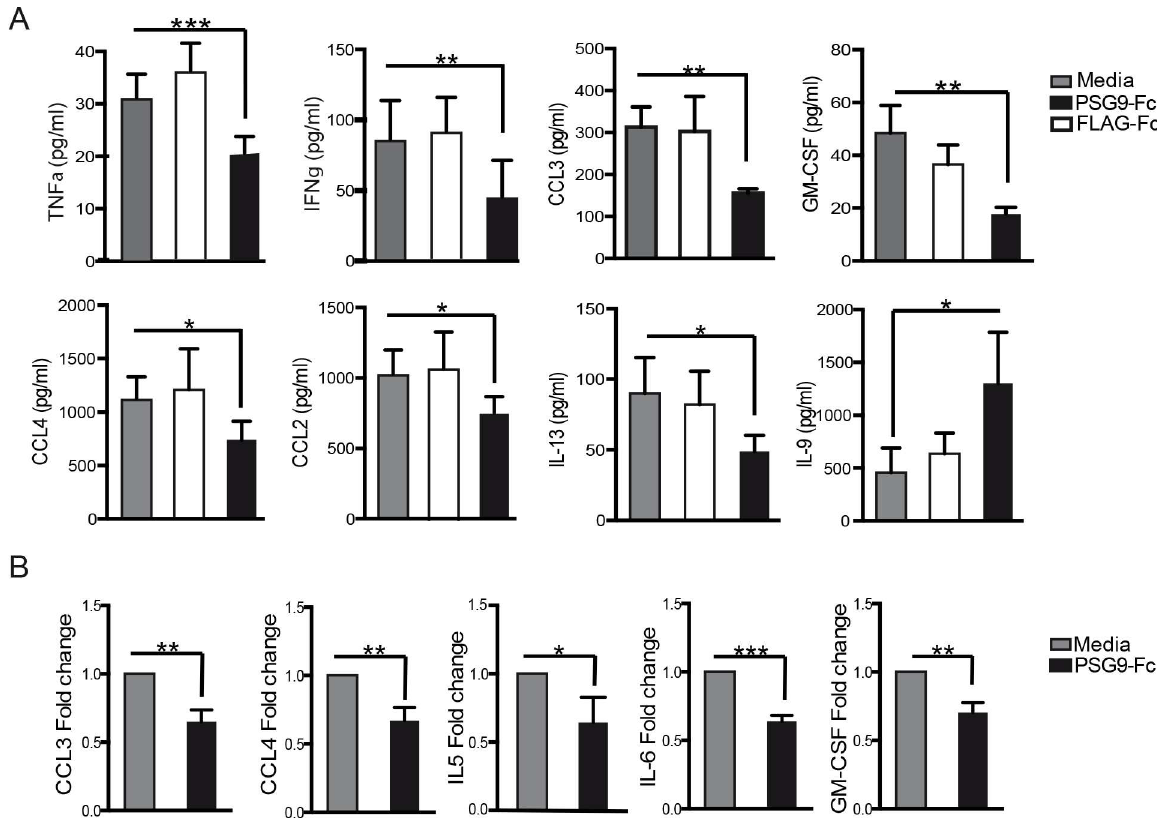
Fig 8. Pro-inflammatory cytokine expression is reduced upon T-cell treatment with PSG9. Supernatants from naive CD4 + mouse (A) or human(B) T-cells were collected 72 h after activationand treatment with PSG9 or FLAG. Cytokineconcentrations were measuredusing multipleximmunoassay kits with the Bioplex system. P values were calculatedby Student’s t -tests. * P < 0.05, ** P < 0.005, *** P < 0.0005, **** P < 0.0001.